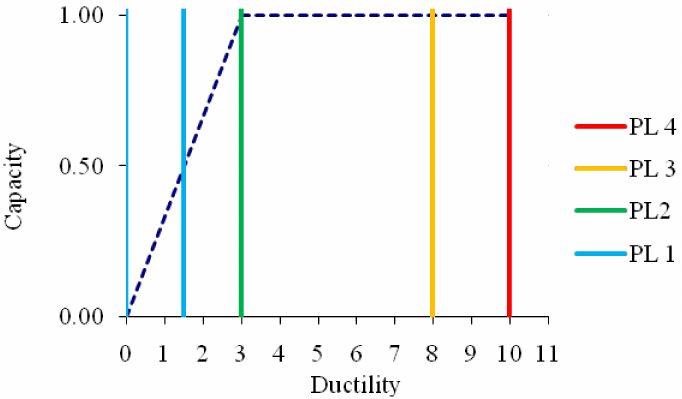
Figure 4. Relationship between plastic hinges (moment rotation curve) and performance levels. For the infill panels, truss elements are used only for the axial compressive forces. Axial force-axial displacement hinges are based on infill panels’ characteristics. The maximum resistance of a truss model is based on material properties. Elastic-plastic hinges are considered, which are defined by means of the yielding point, maximum strength and ultimate displacement point of the truss element based on the drift (1.25‰ and